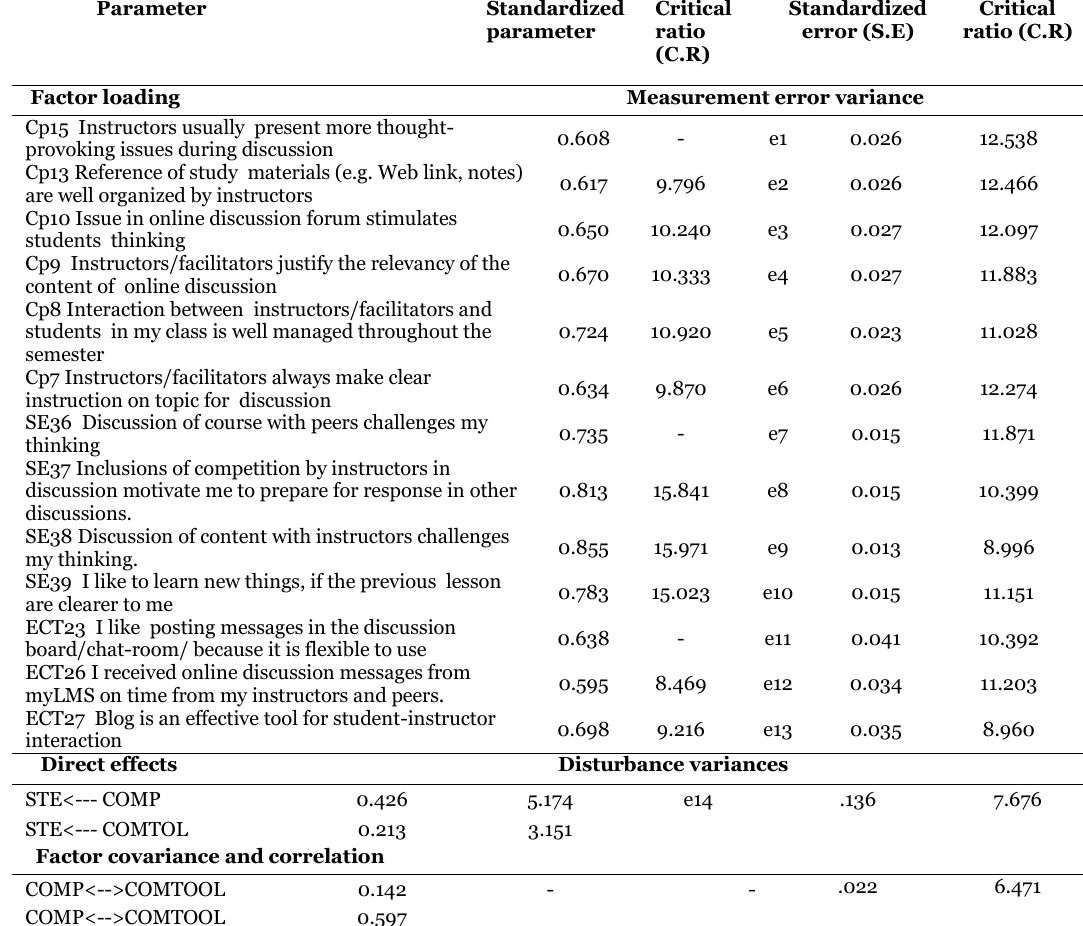
Maximum Likelihood Parameter